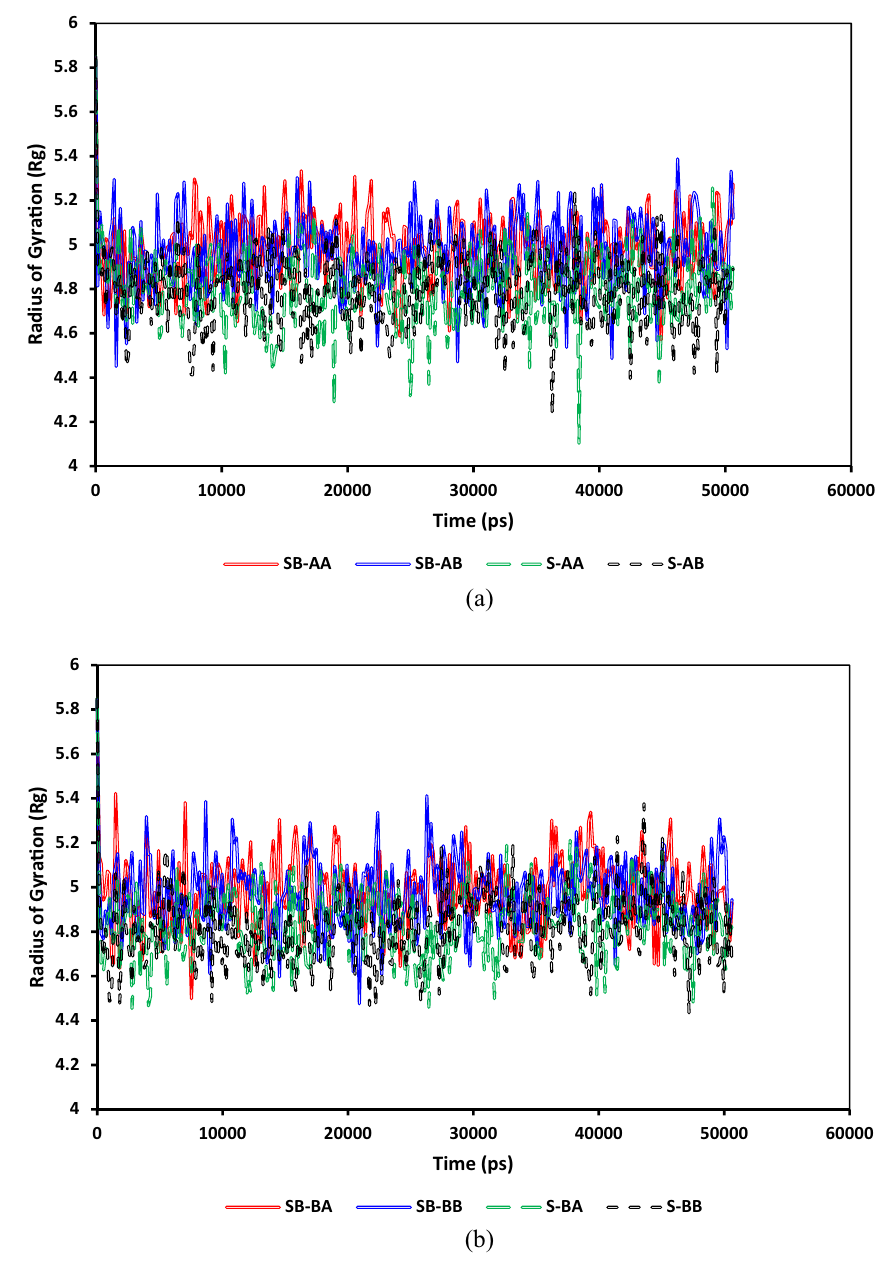
Figure 11. Comparison between the radii of gyration of anionic surfactants in systems containing ( a ) C 40 H 30 O 2 and ( b ) C 44 H 40 N 2